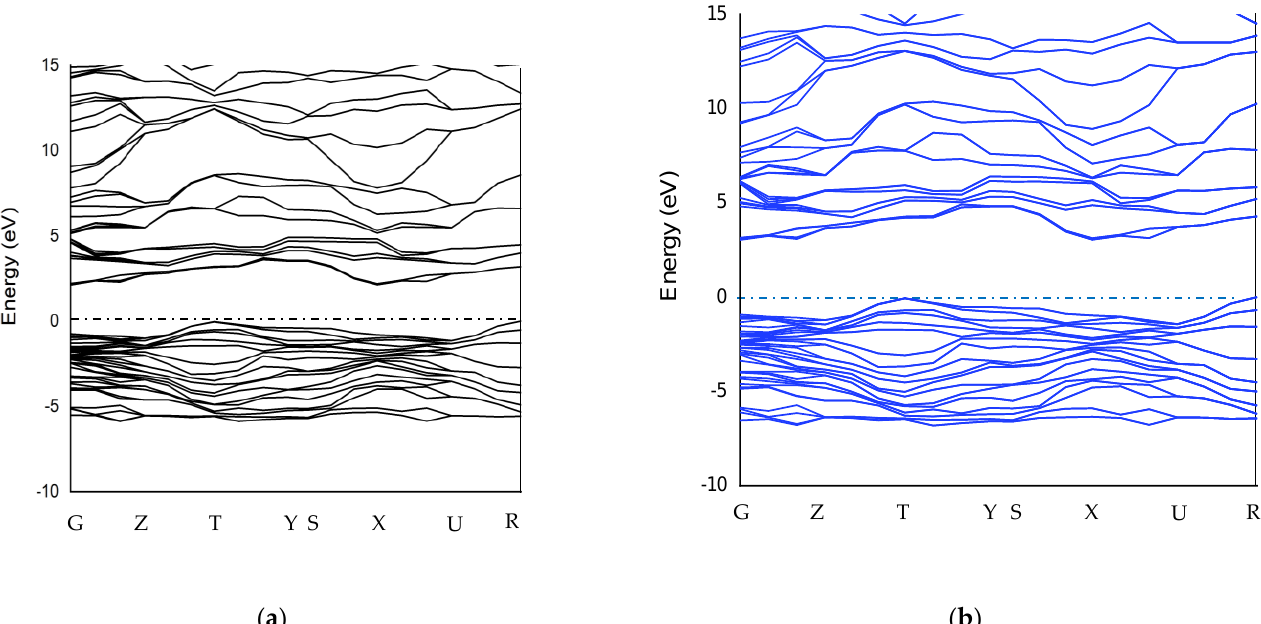
Figure 3. Band structure of MoO 3 calculated using PBE functional ( a ) and HSE06 hybrid functional ( b ).